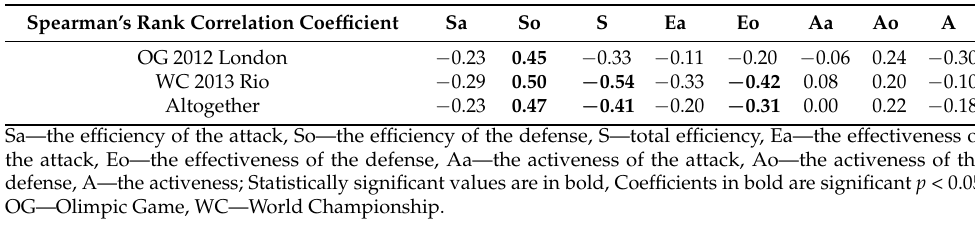
Table 5. Relationship between the indicators of technical and tactical preparations and the rank in the general classification of the analyzed